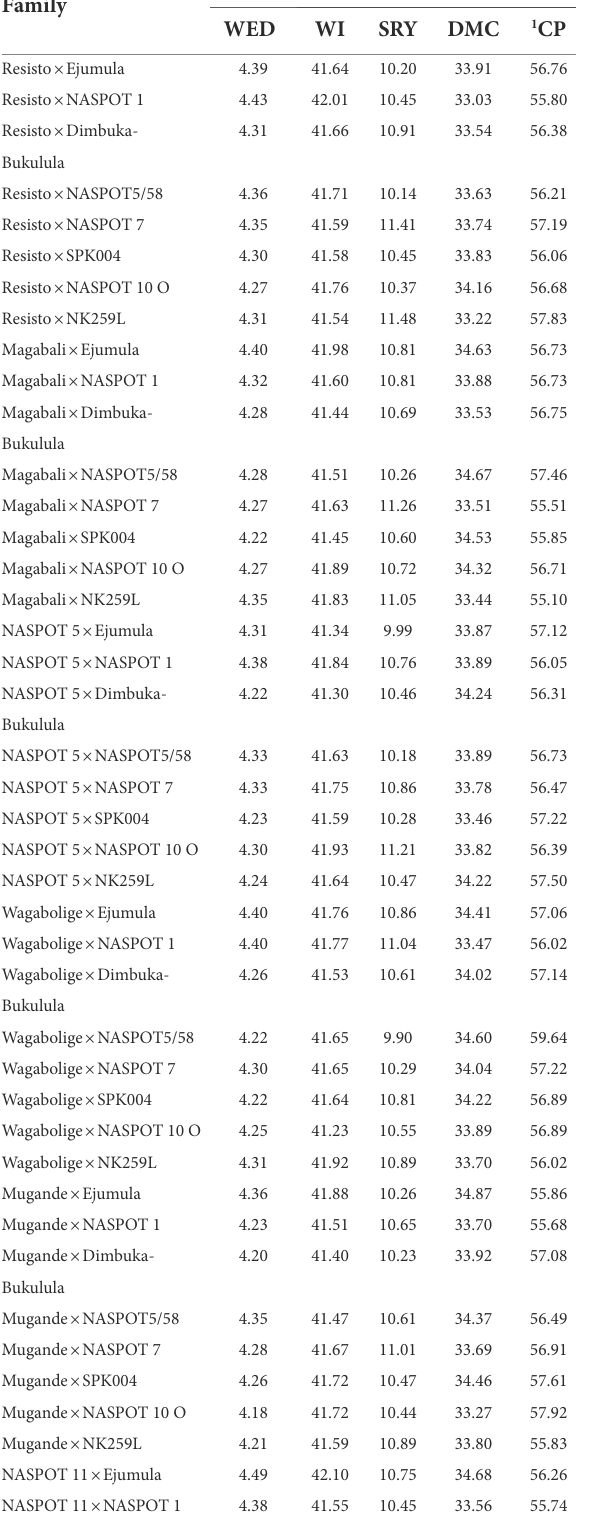
TABLE 7 Specific combining ability (SCA) predictions for weevil severity (WED, scale 1–9), weevil incidence (WI, %), storage root yield (SRY, t/ha), dry matter content (DMC, %), and number of emerged adult weevils (CP) for the 64 sweetpotato